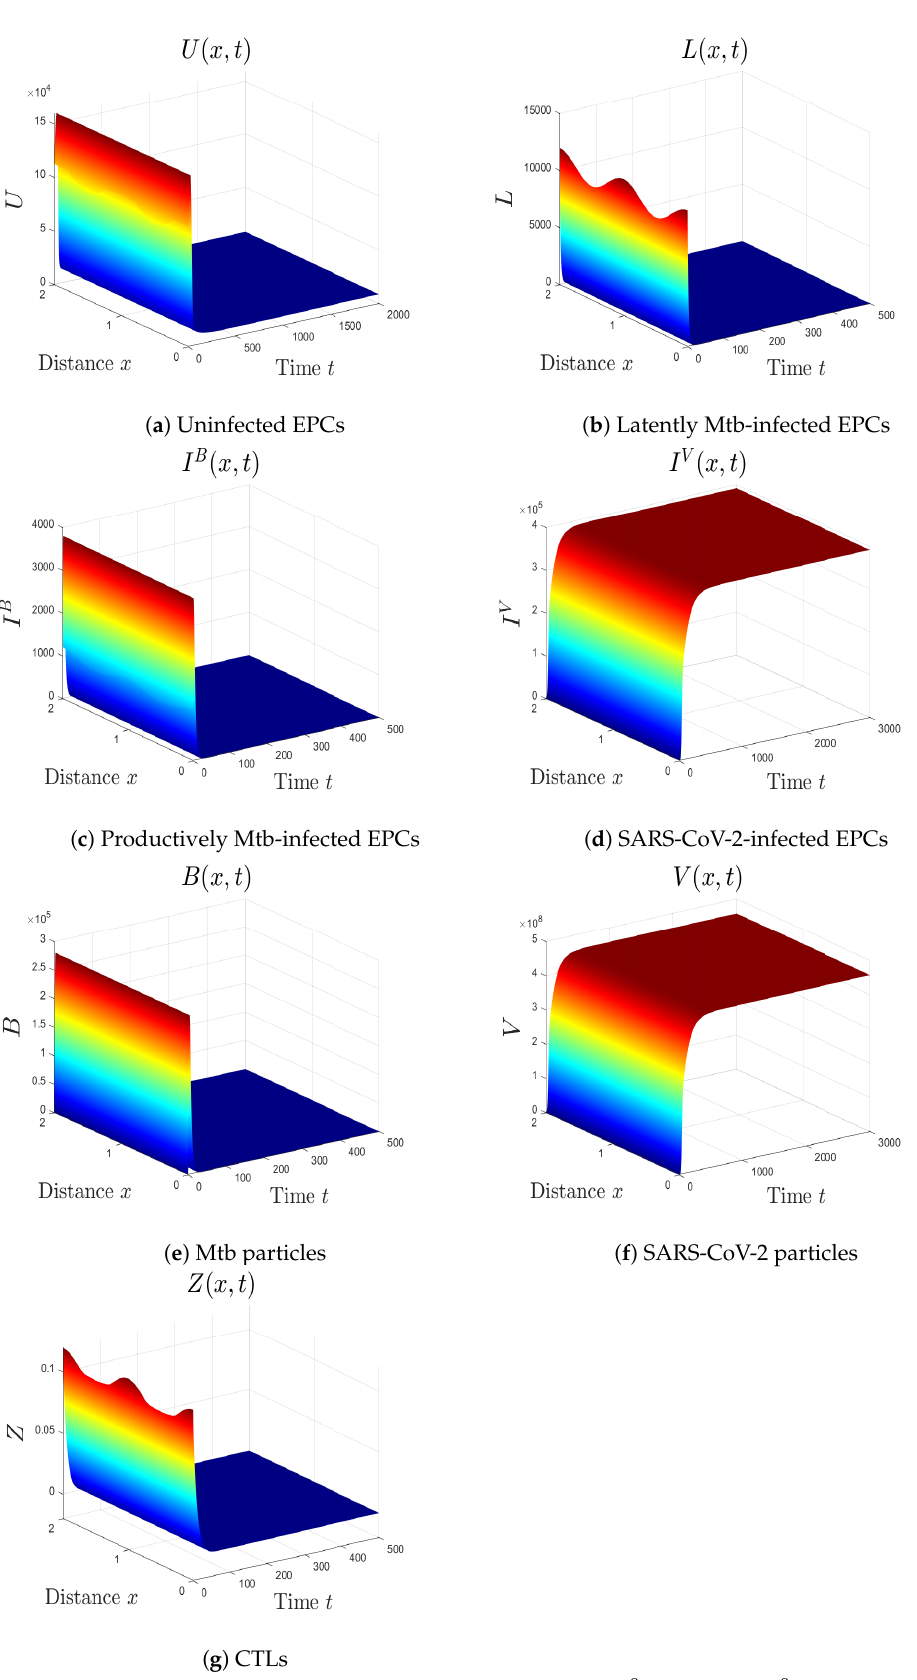
Figure 3. The numerical results of system (1) for η 1 = 2.5 × 10 − 9 , η 2 = 1 × 10 − 9 , and ω = 1 × 10 − 8 . (cid:0) The equilibrium E 2 = 8571.43,0,0,391,429,0,4.56667 × 10 8 ,0